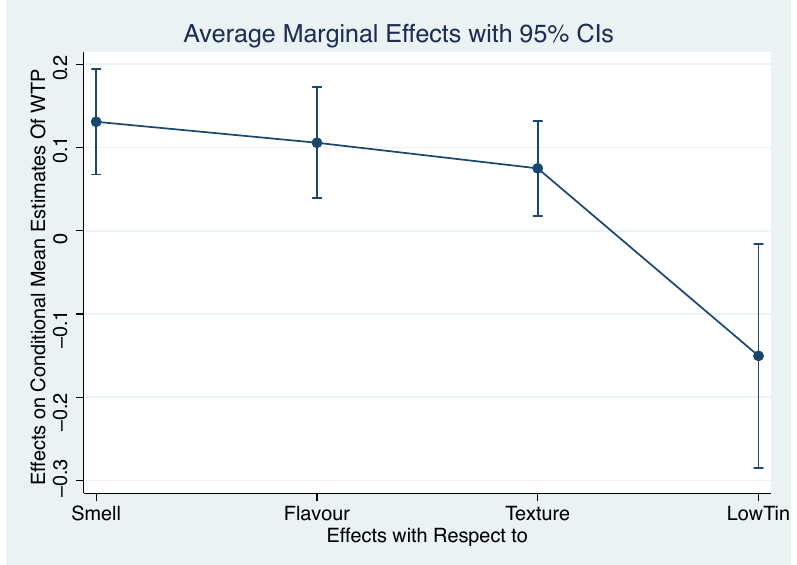
Figure 4. Overall liking and WTP of respondents with a WTP > 0 (88 respondents on 249